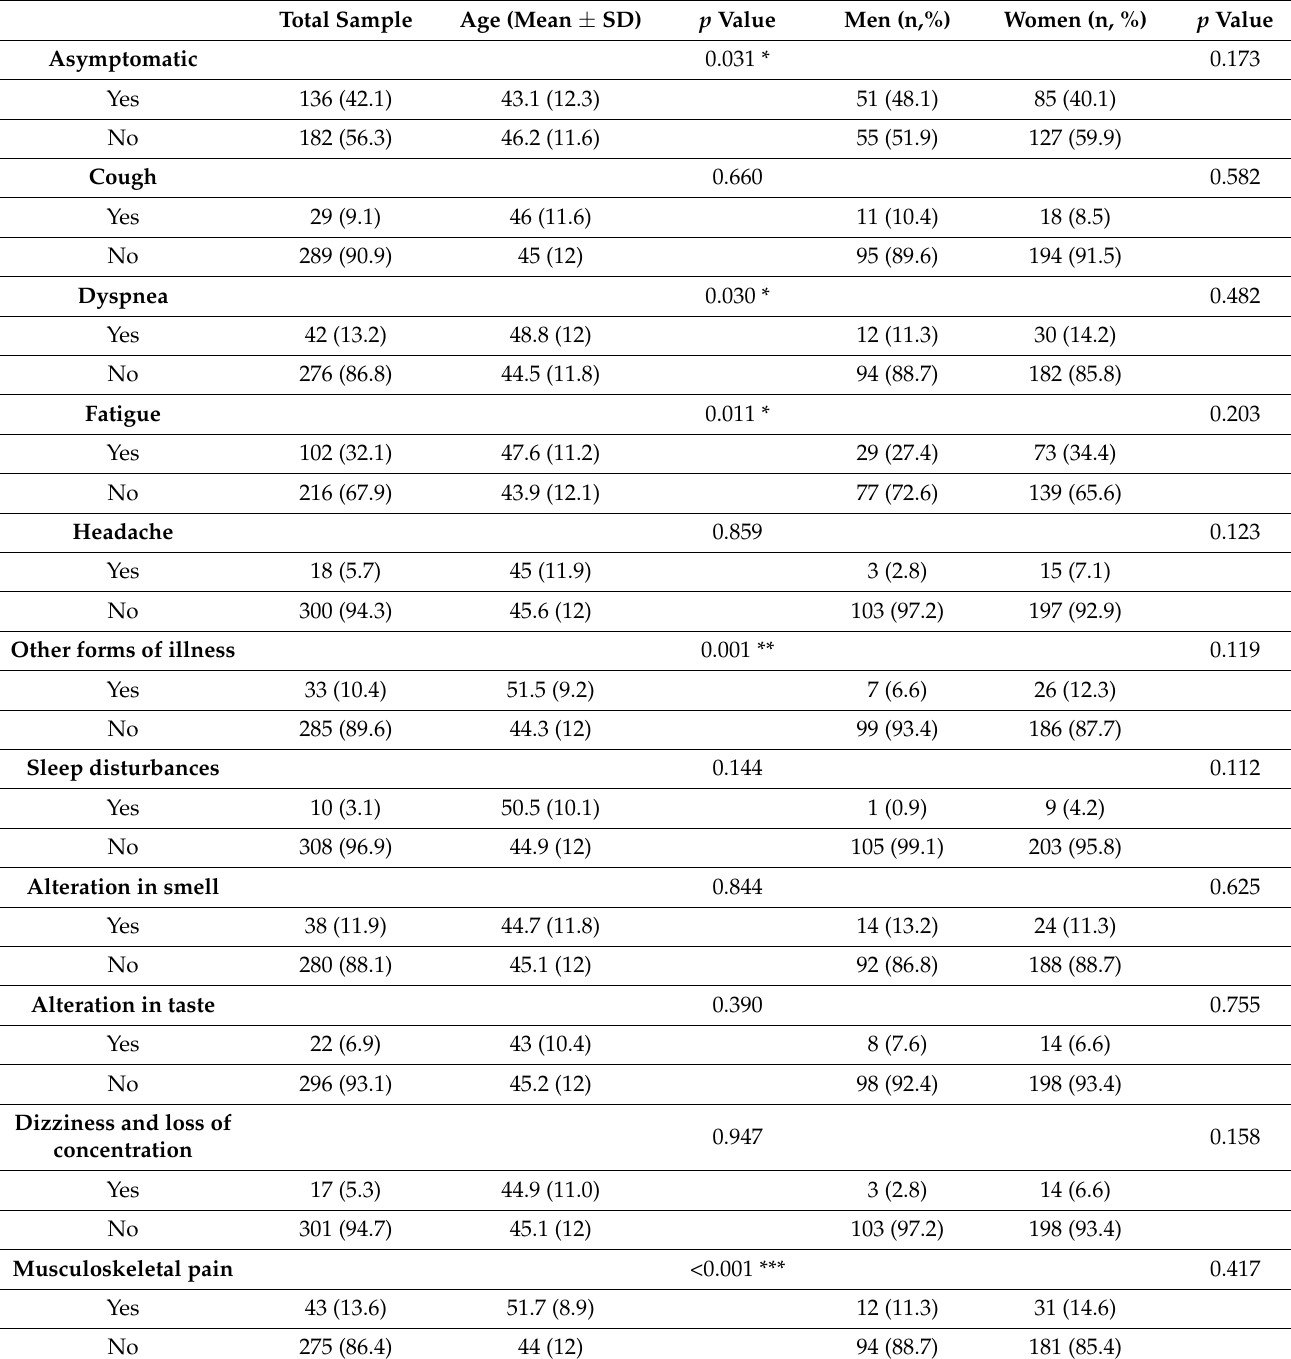
Table 1. Reported post-COVID-19 symptoms in the whole sample and segregated by sex. The table also shows the mean age according to the presence of specific post-COVID-19